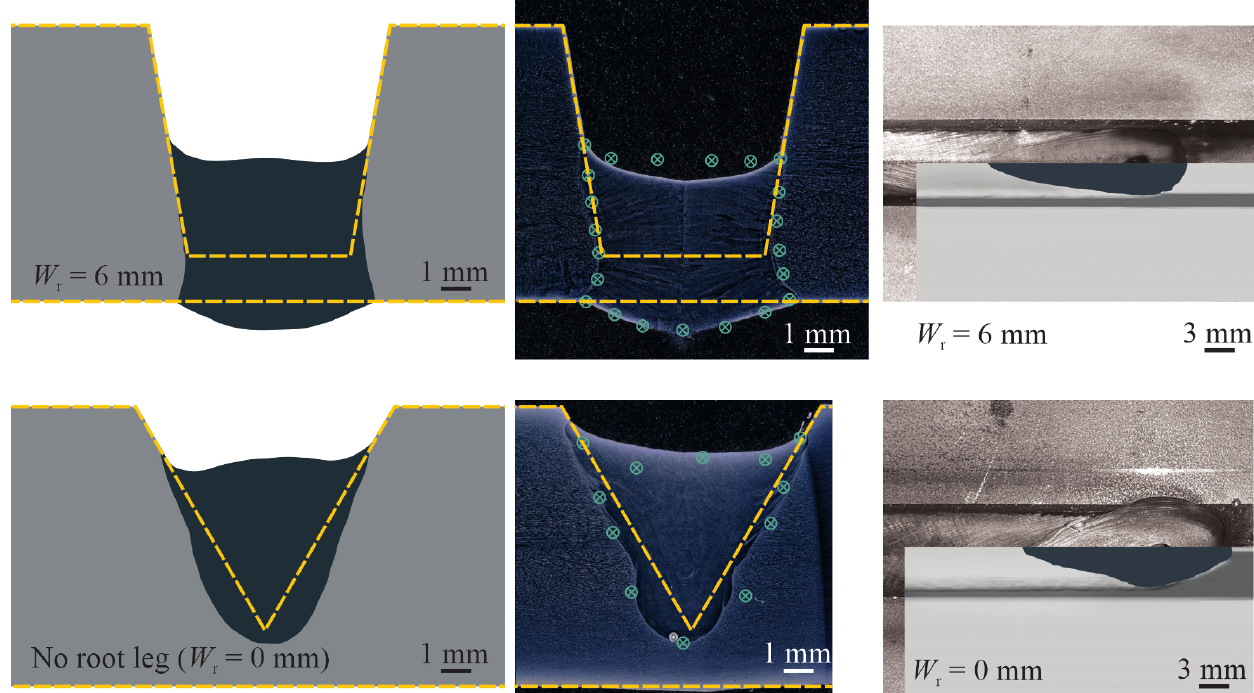
Figure 4. Comparison of the melt-pool shapes obtained from the present numerical simulations with experimental measurements for different groove shapes with a welding current of 280A and a travel speed of 7.5mms − 1 . Regions shaded in dark grey show the melt-pool shape obtained from numerical simulations. The computational cells that, at any stage during the transient calculations of the melting and re-solidification process, contained molten metal were marked to visualise the melt-pool shape on the transversal cross-section. Green symbols on experimental data show the melt-pool boundary obtained from numerical simulations. Yellow dashed-lines indicate the joint shape before